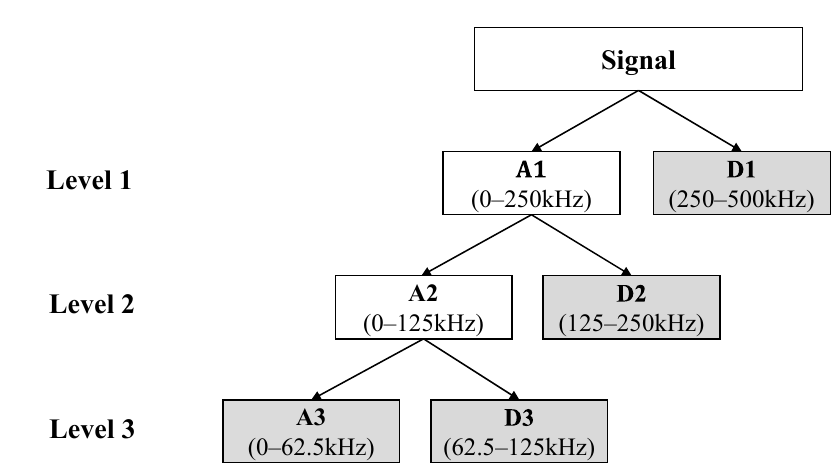
Figure 10. A decomposition tree structure of three-level discrete wavelet transform (DWT) decomposition and result of decomposition (A3 and D1–D3).